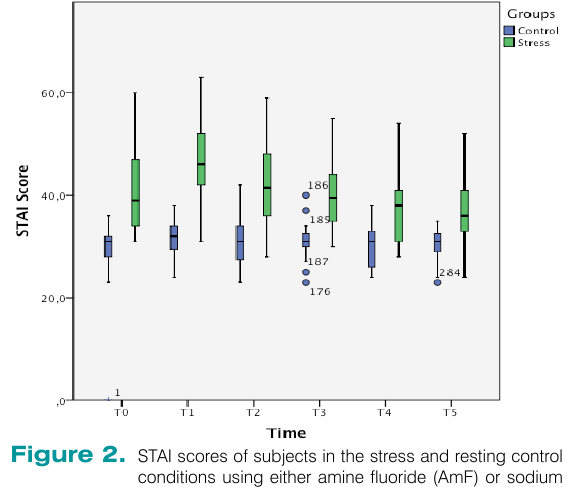
Figure 2. STAI scores of subjects in the stress and resting control conditions using either amine fluoride (AmF) or sodium fluoride (NaF) before (baseline) and immediately after the public speaking task (T1) and immediately (T2), 10 (T3), 30 (T4) and 120 (T5) minutes after tooth brushing. Higher STAI scores indicate elevated state anxiety (results of post-hoc t-tests (collapsed stress vs. resting control groups)).